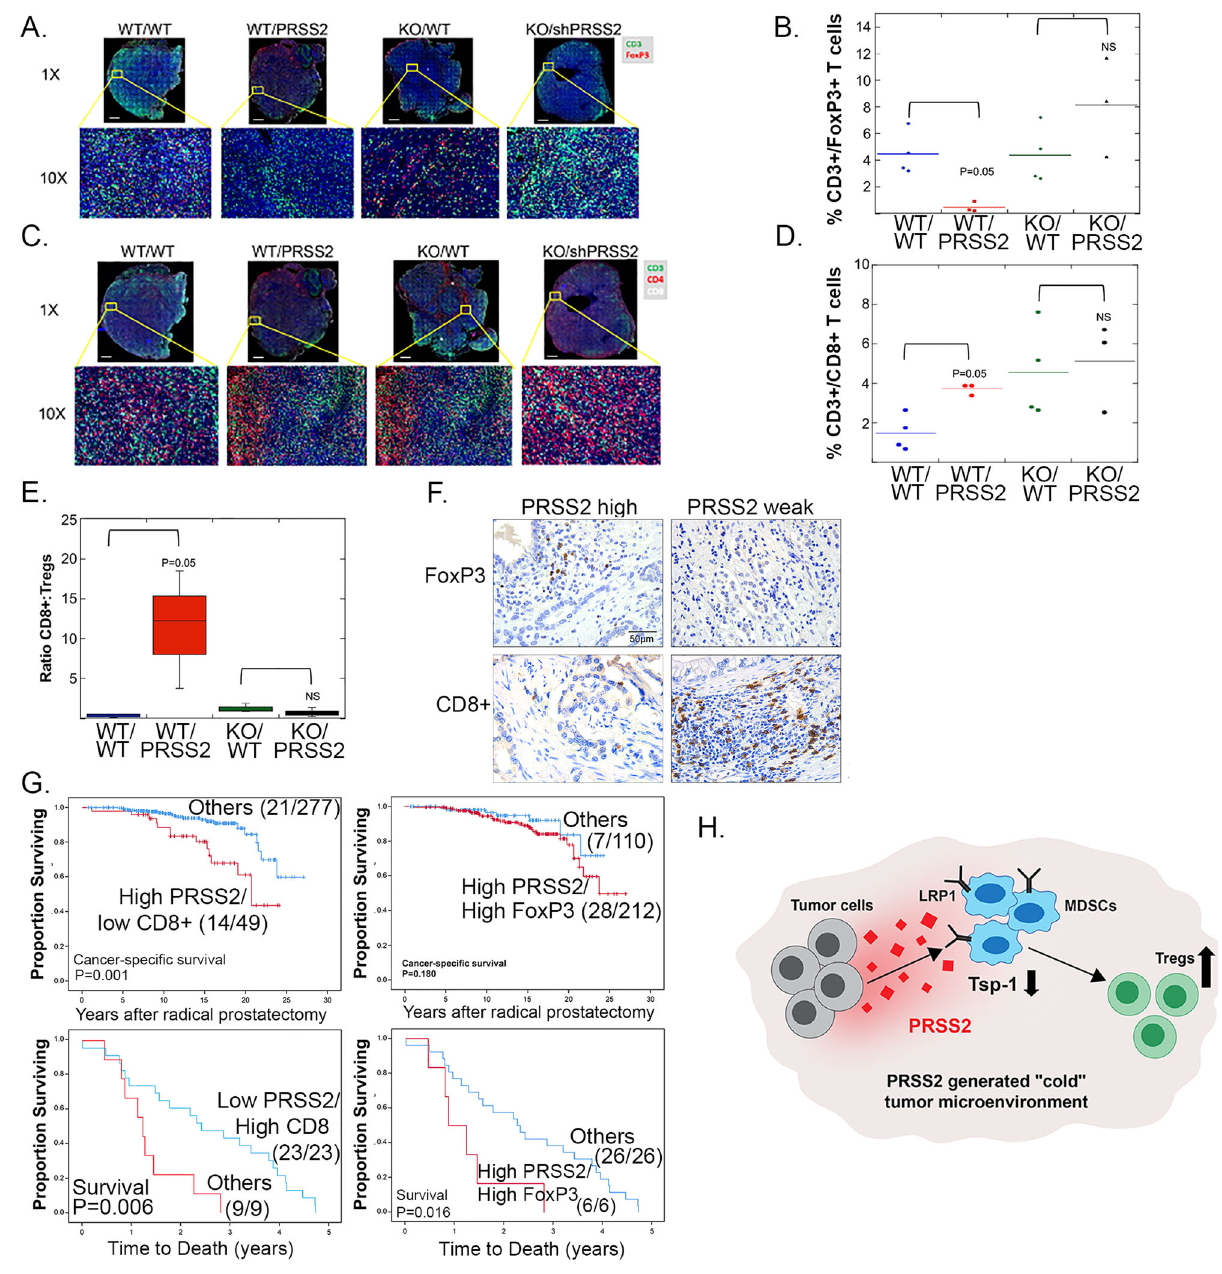
Fig. 7 | Repression of Tsp-1 by PRSS2 creates and immunosuppressive TME. A Immuno fl uorescence staining of CD3 (green) and FoxP3 (red) in tumors formed by Pan02 ( n =4) and Pan02shPRSS2 ( n =3) cells in WT C57Bl6/J mice and Tsp1 − / − C57Bl6/Jmice(scalebar=1mm). B Plotof thepercentageofCD3+/FoxP3+ Tcells out of total CD3+ T cells in tumors formed by Pan02 ( n =4) and